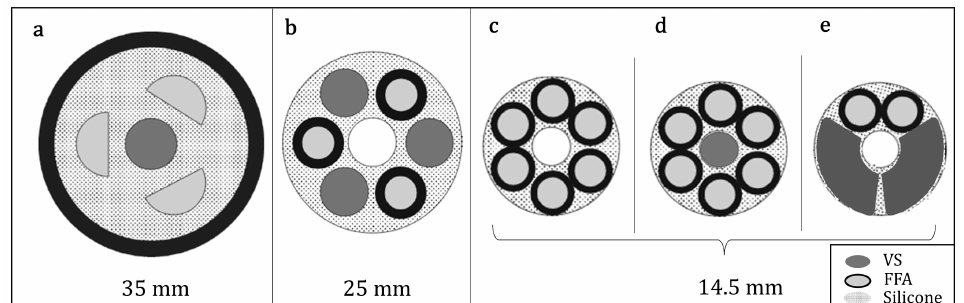
Figure 1. ( a ) Original STIFF-FLOP design ( b ) design with modified actuators design ( c – e ) miniatur- ized